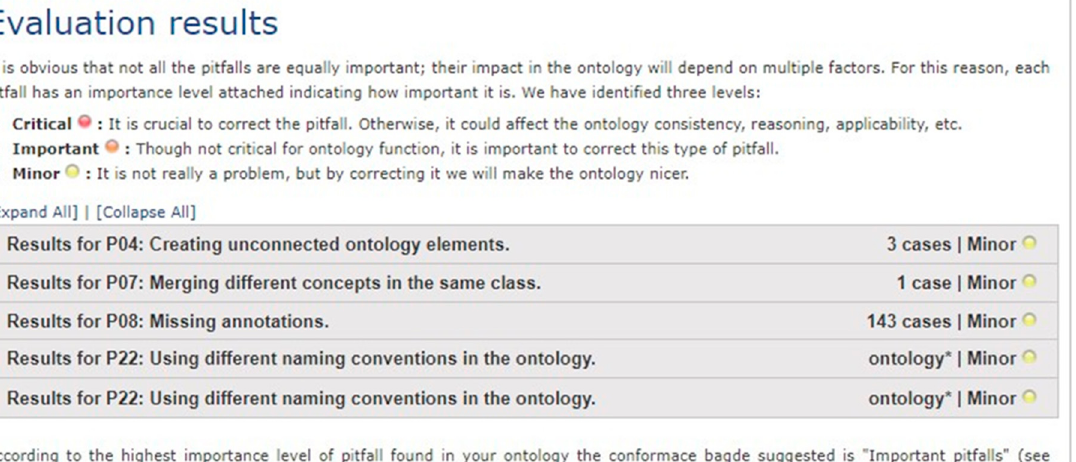
Figure 9. Evaluation results of implemented ontology on Ontology Pitfall Scanner (OOPS!).